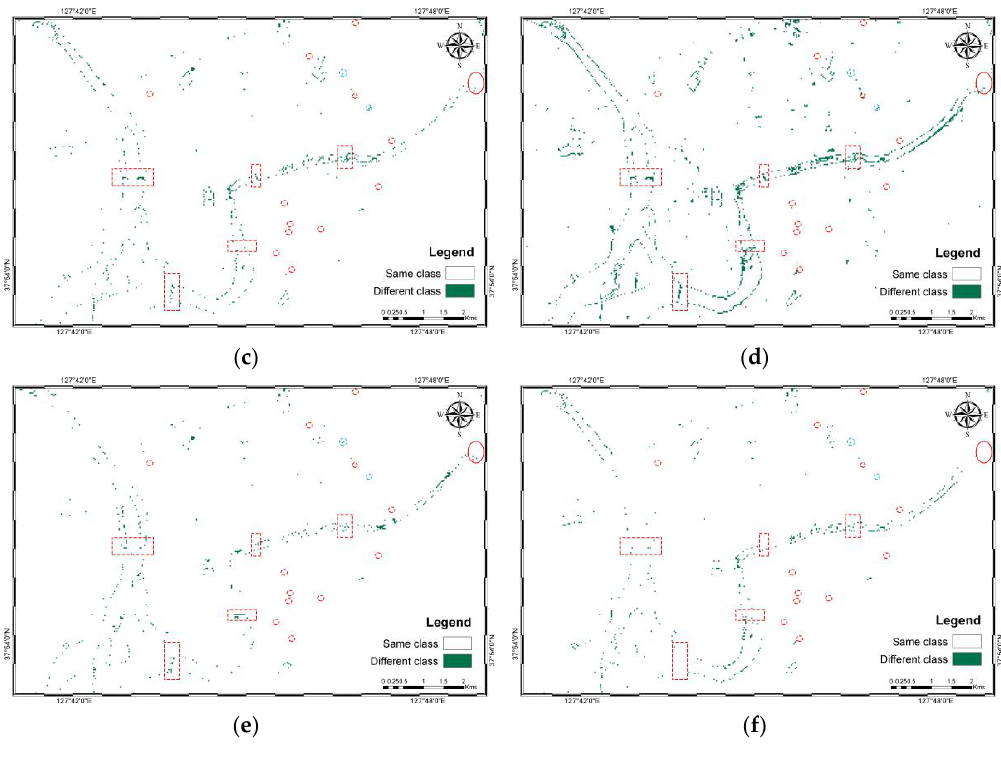
Figure 6. Comparison of classes derived with respect to JDT: ( a ) Water bodies identified by JDT with water boundaries extracted from digital topographic map ver. 2.0 ( b ) JDT and Density Slicing ( c ) JDT and NDWI; ( d ) JDT and MNDWI; ( e ) JDT and ML and ( f ) JDT and SVM. Similar to Figure 5, the red dotted boxes, red oval, red dotted circles and light blue dotted circles show bridges, a dam, unidentified water bodies and identified water bodies,